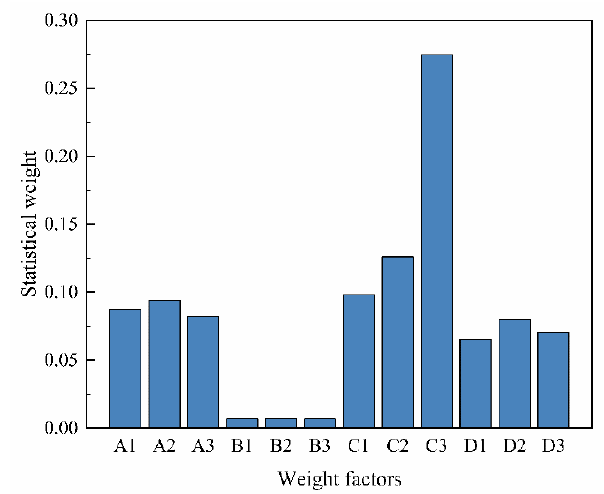
Figure 3. Comprehensive statistical weight of each weight